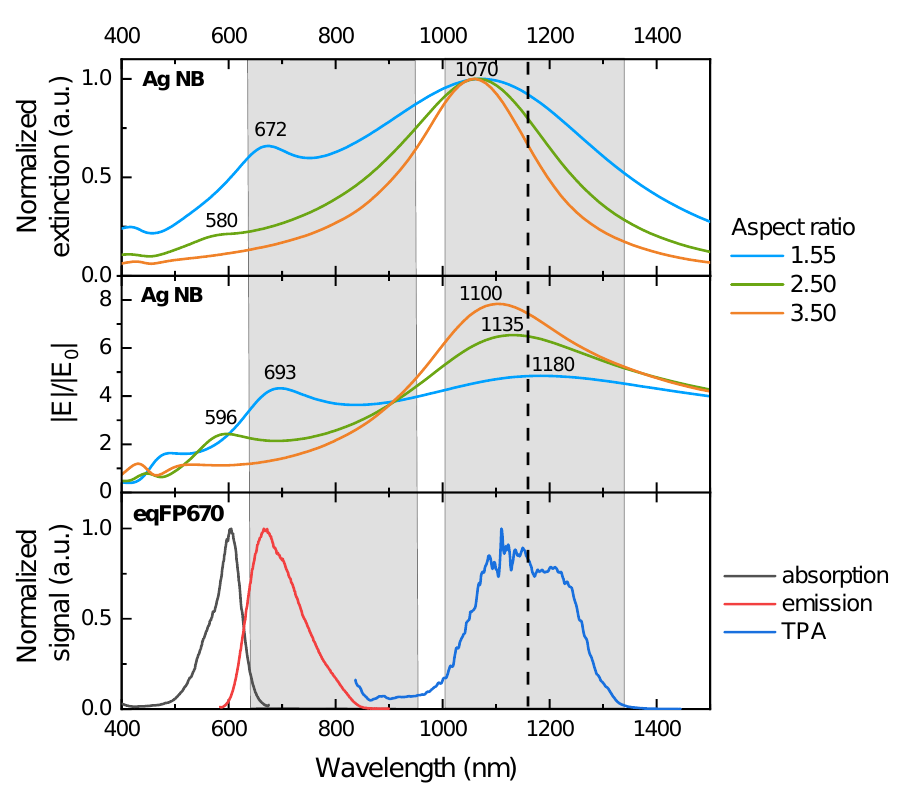
Figure 3. Spectral properties of the system under study. Top and middle: normalized extinction and electric field enhancement near Ag NB with l = 220 nm and various aspect ratios. Bottom: normalized absorption (black), emission (red) and two-photon absorption (blue) spectra of eqFP670 [5]. The dashed line marks the irradiation wavelength. The grey regions demonstrate the two biological transparency